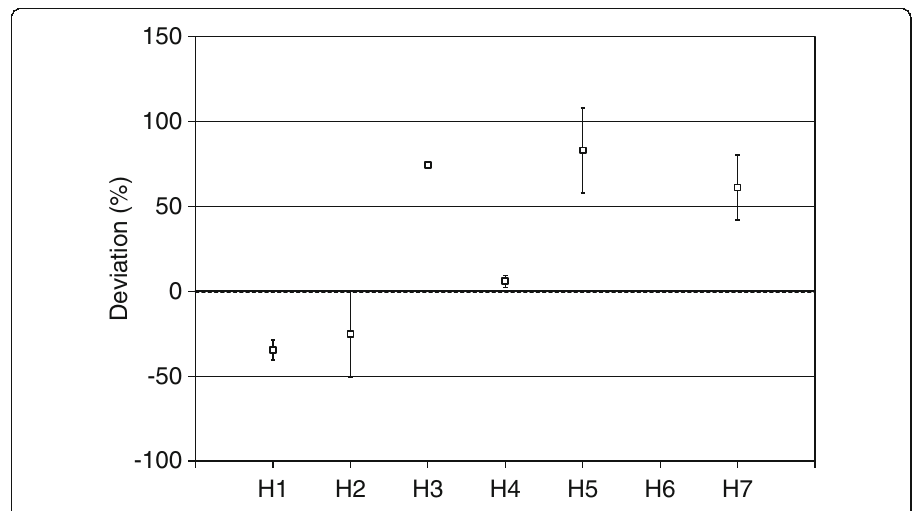
Fig. 7 Participants reported activities for the outer shell of the comparison source